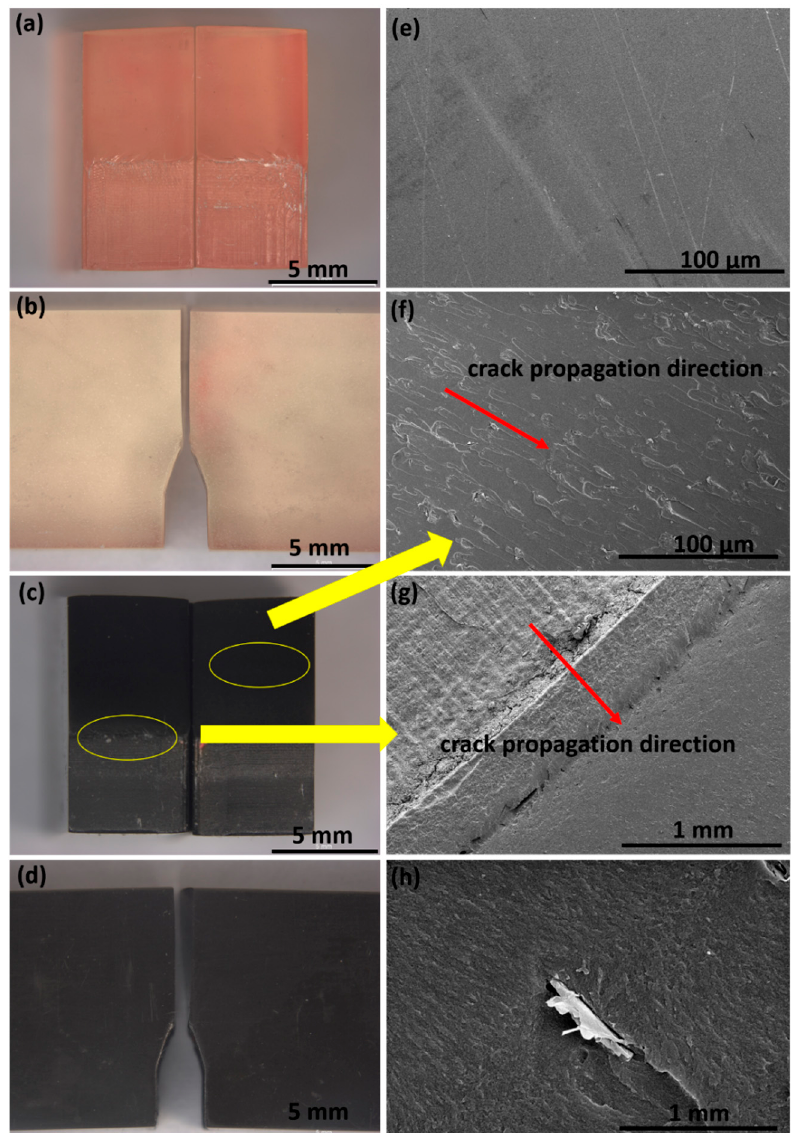
Figure 7. Optical microscopy images of fracture surface and fractured lateral view of graphene/resin composites after a successful fracture toughness test: ( a , b ) the neat resin specimens; ( c , d ) 0.5 wt.% nanocomposite specimens. SEM images of the fracture surfaces of: ( e ) the neat resin; ( f ) 0.5 wt.% nanocomposites; ( g ) magnification of the circled domain in ( c ); and ( h ) a pulled out graphene sheet.